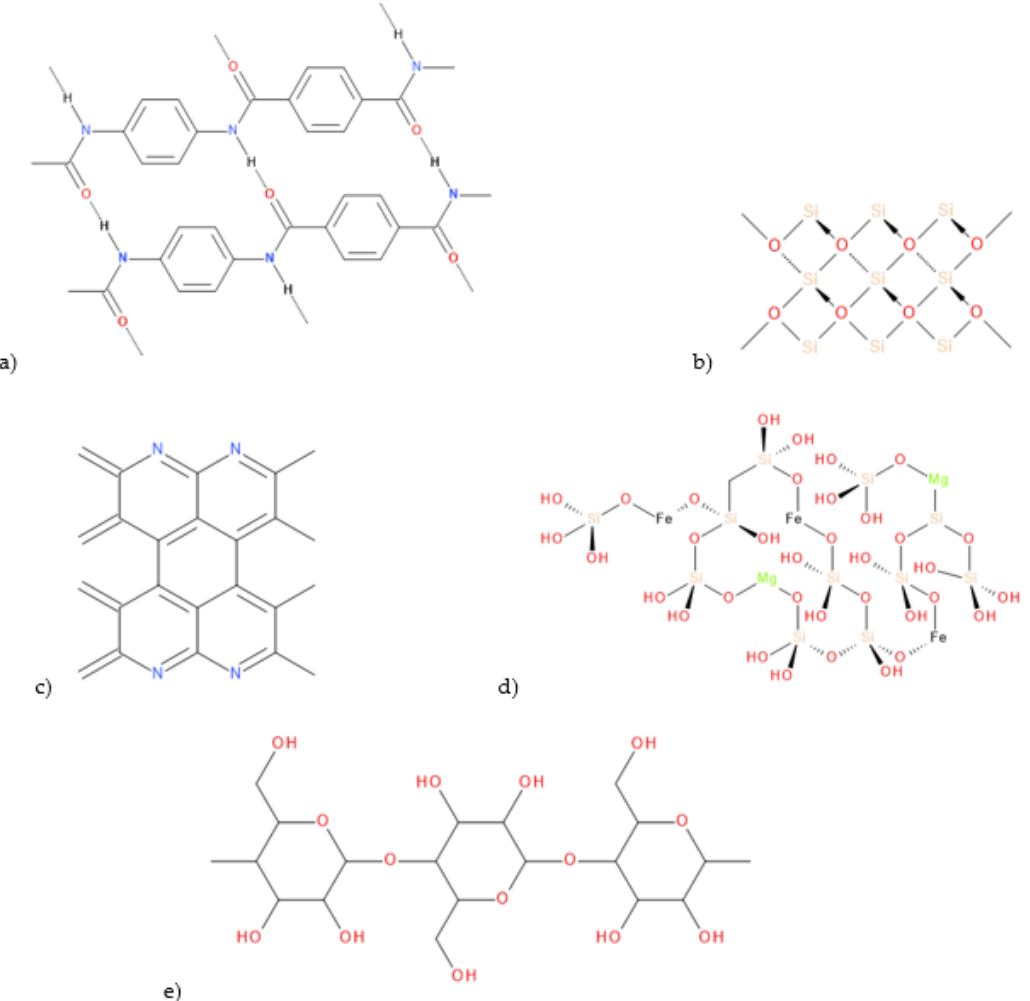
Figure 6. Chemical structure of the fibers: aramid fiber (AF) ( a ), glass fiber (GF) ( b ), carbon fiber (CF) ( c ), basalt fiber (BF) ( d ), flax fiber (FF) ( e ).